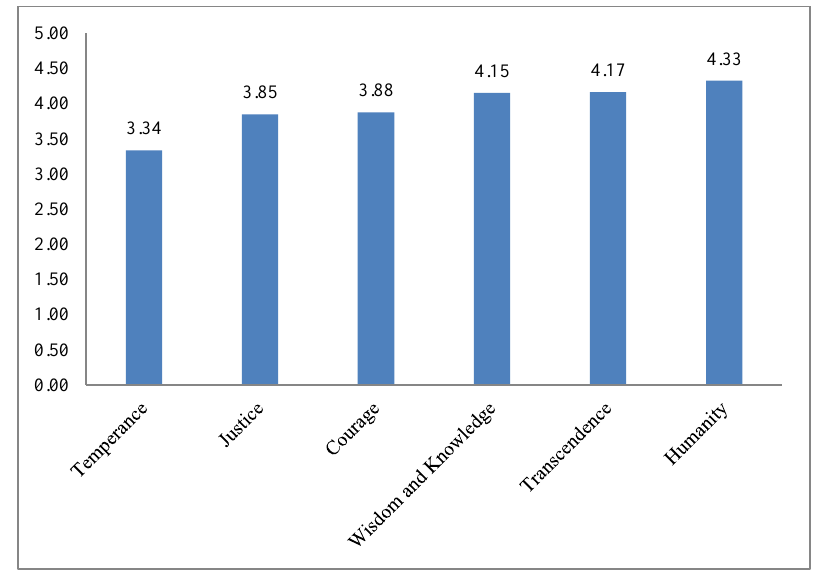
Fig. 8. Mentor teachers’ virtues (means, rated on a 5-point scale, N=86) The strongest correlation exists between Transcendence and Wisdom (r=0.555;